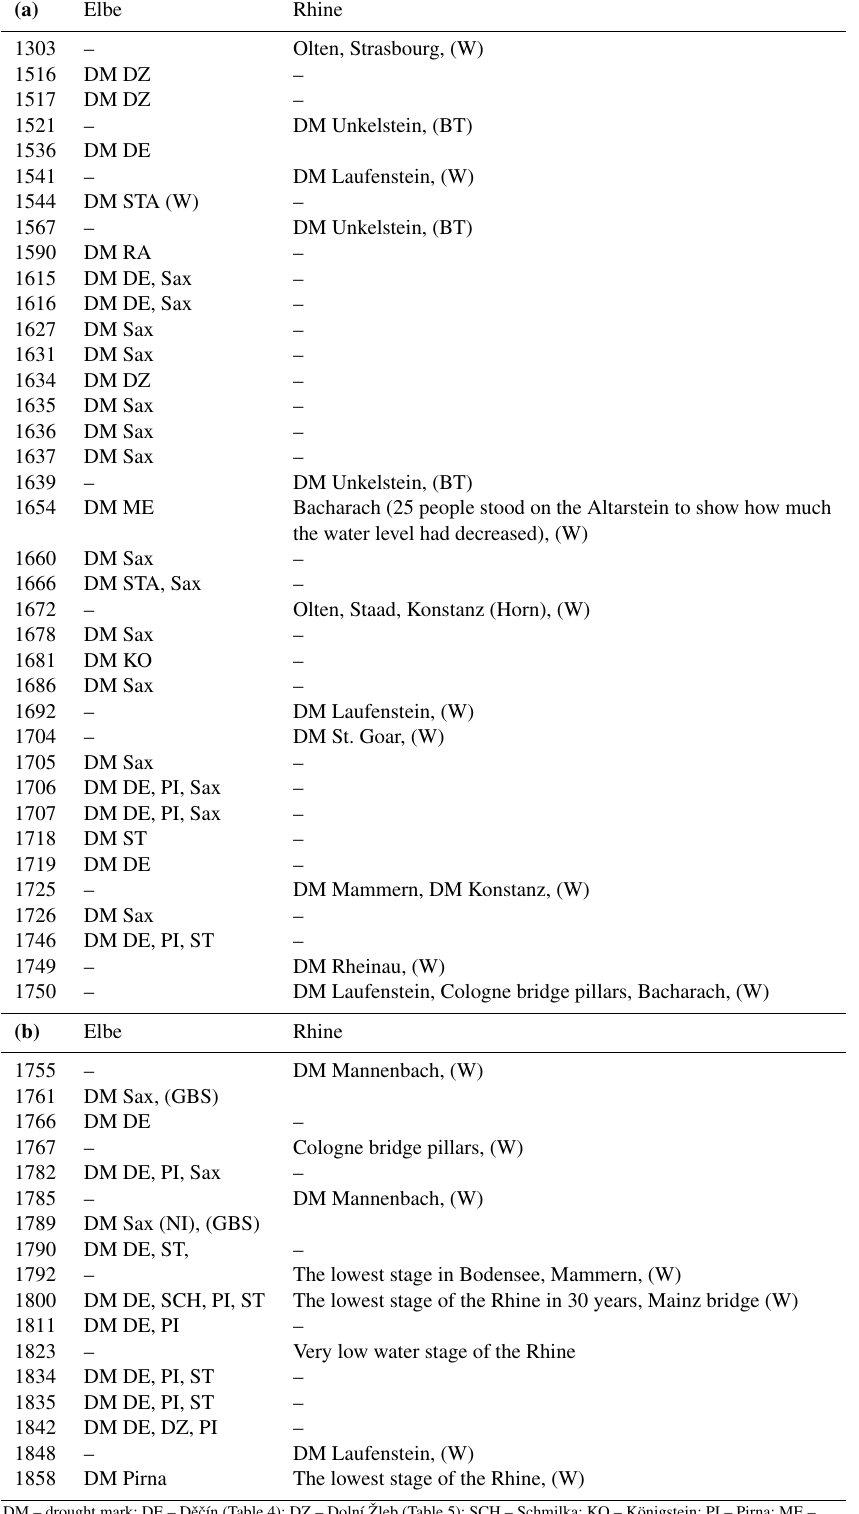
Table 11. Documentation of minimum water levels in the Rhine basin according to Wittmann (1859) and of the Elbe minima on the basis of documented DMs from (a) 1303 to 1750 and (b) 1755 to